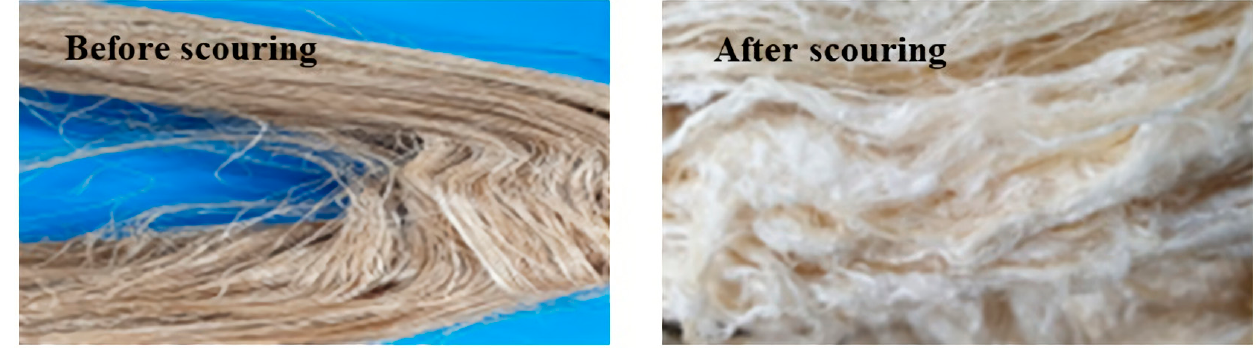
Figure 11. Before and after treatment of natural fiber.